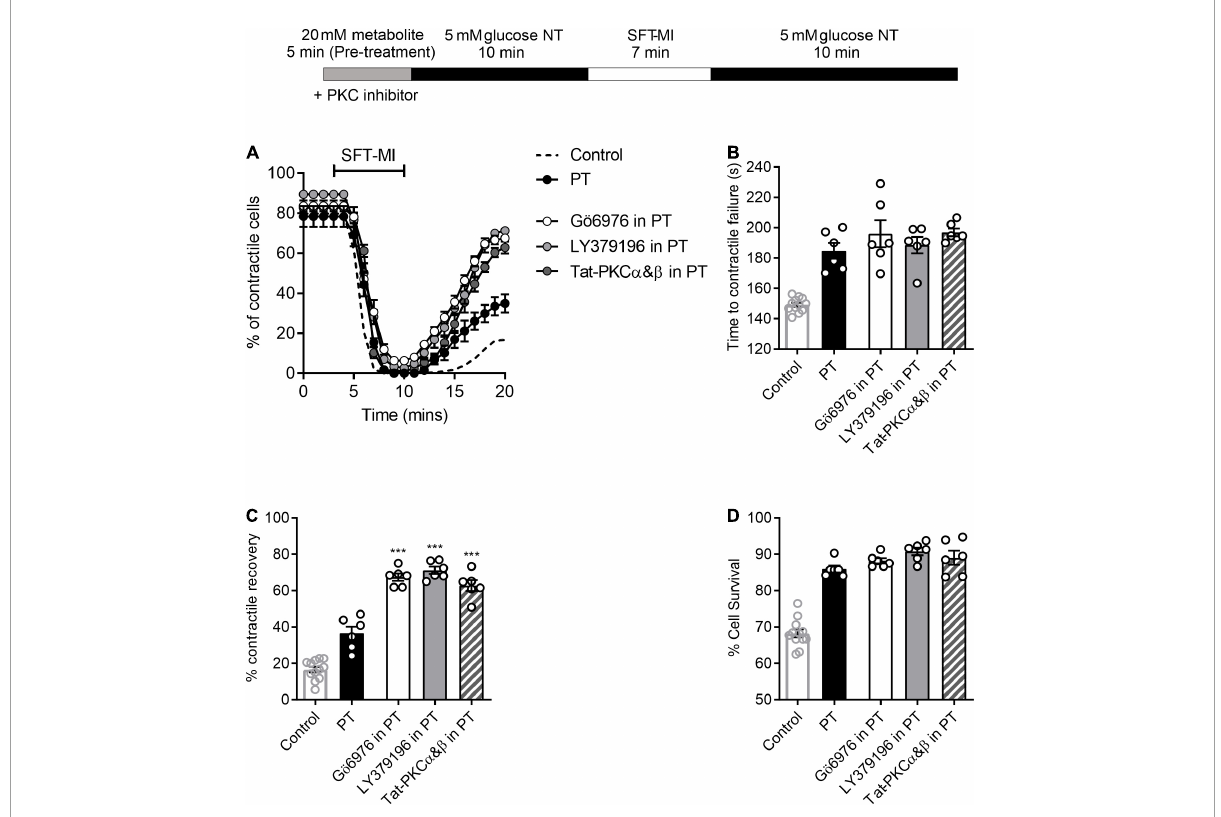
FIGURE7 PKC α and/or β -selective inhibitors enhance the protected phenotype imparted by short high glucose pre-treatment. (A) Time course showing the percentage of contractile cardiomyocyte throughout the metabolic inhibition protocol following high glucose pre-treatment with or without PKC inhibitors, as indicated. (B) Bar chart showing the mean time to contractile failure, (C) mean percentage contractile recovery and (D) mean percentage of cell survival following metabolic inhibition in the absence and presence of selective PKC inhibition and with or without pre-treatment [*** p < 0.001, One Way ANOVA with Holm-Sidak post-test. n = > 6 animals ( > 83 cells) for each data set. Each data set is compared to PT in the absence of PKC inhibitor. Control (no PT) data shown for